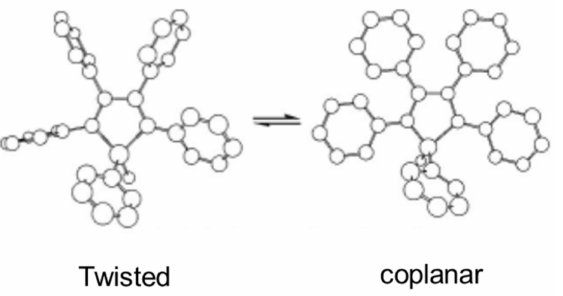
Figure 5. Conformational rotamers of SiPhMe. Republished from [55] with permission of Royal Society of